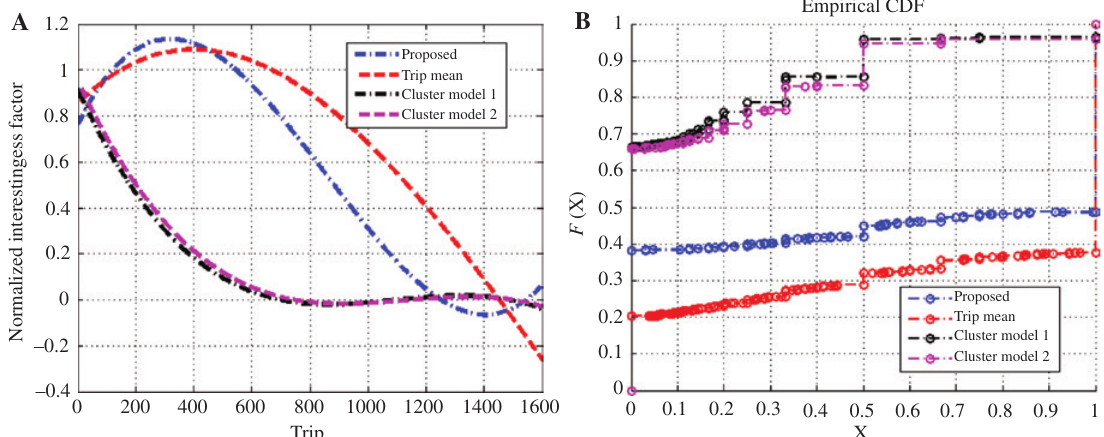
Figure 6: Performance Comparison Using (A) Normalized Interestingness Factor Over Every Trip Plan and (B) Its Distribution for Zero Tolerance.